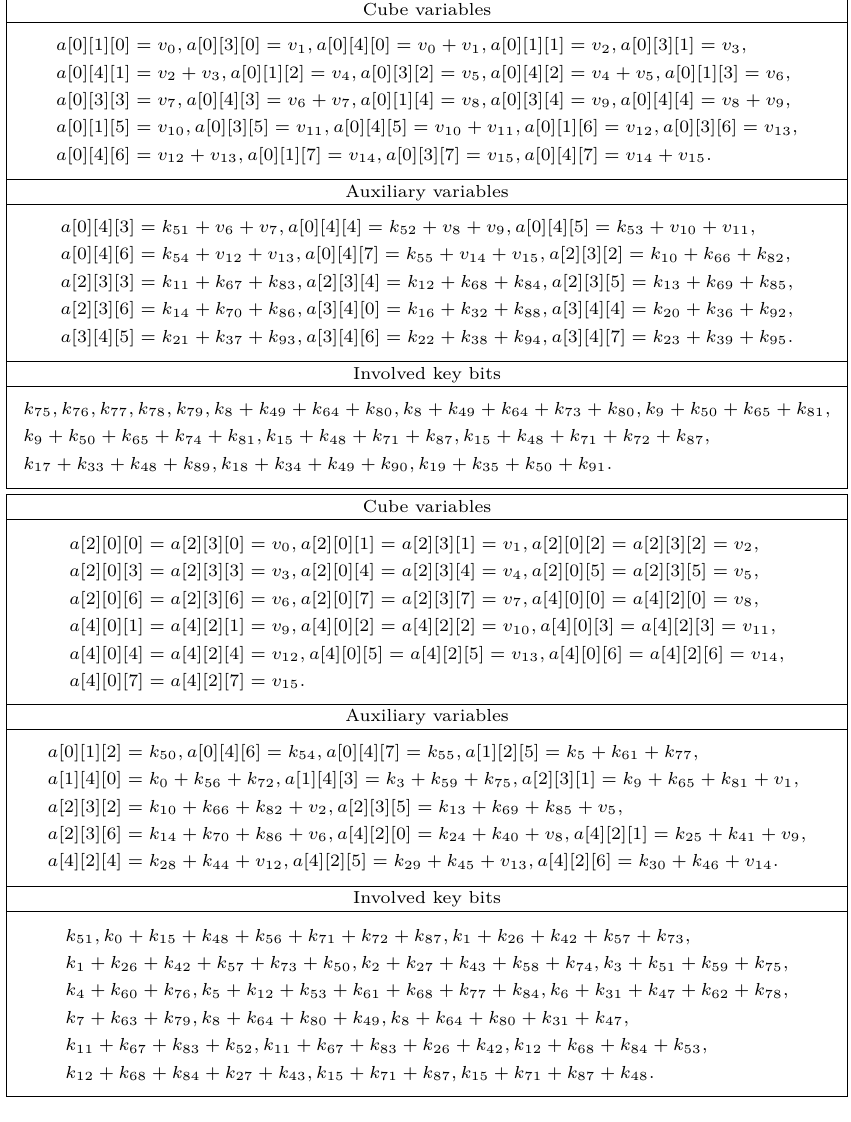
Table 10: The first two 16-dimensional cubes for Ketje Jr V2, where the corresponding ( n a , n i ) are (15 , 14) and (15 , 18), and ( n 0 accumulated numbers of key bits recovered are 29 and